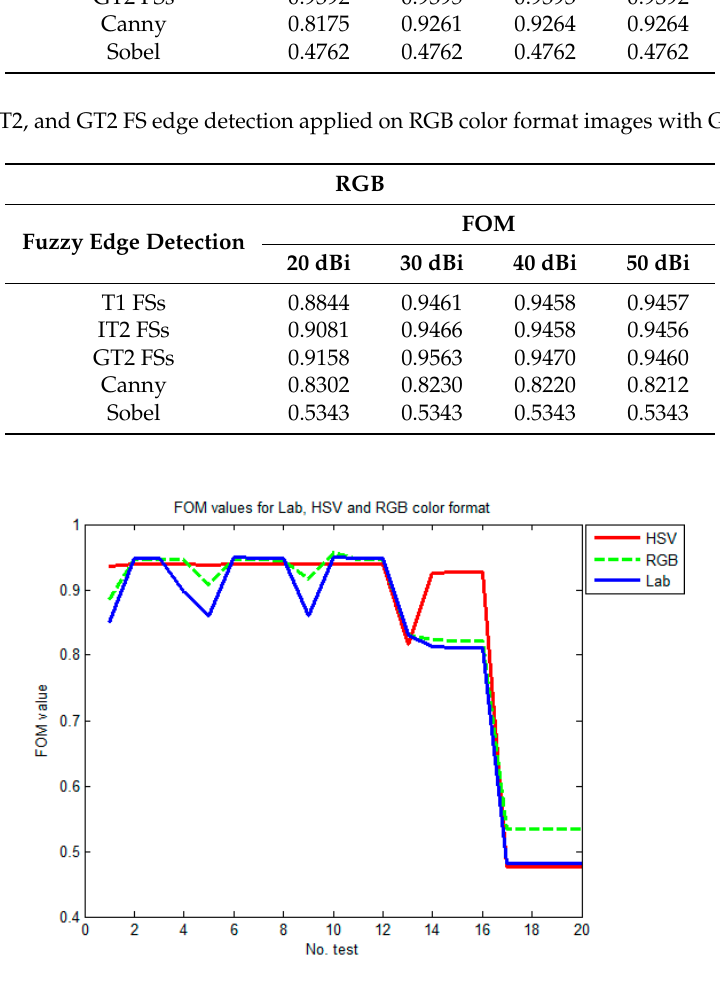
Figure 8. Comparison of results of the FOM values for the different color formats. Table 12. T1, IT2, and GT2 FS edge detection applied on RGB color format images with Gaussian noise.